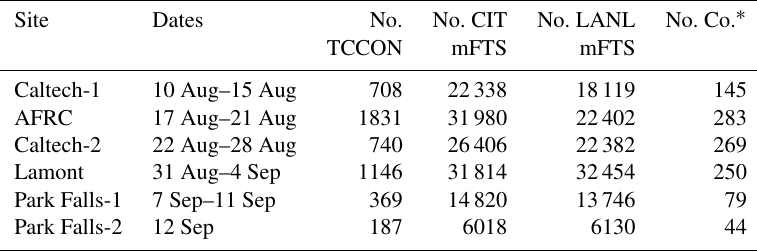
∗ Co. indicates 10min averaged two-way coincident mFTS and TCCON data